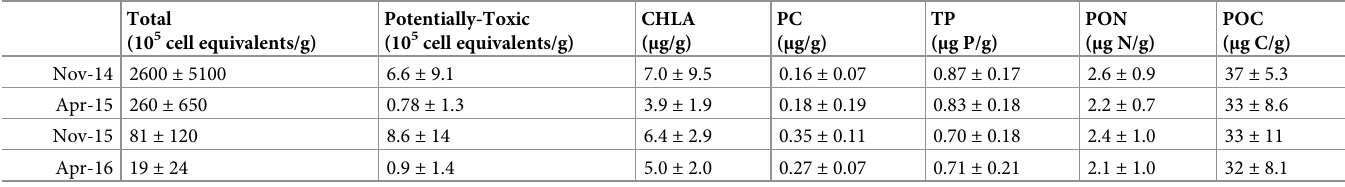
Table 3. Basin-wide averages of measured parameters for each seasonal sampling (Mean ±